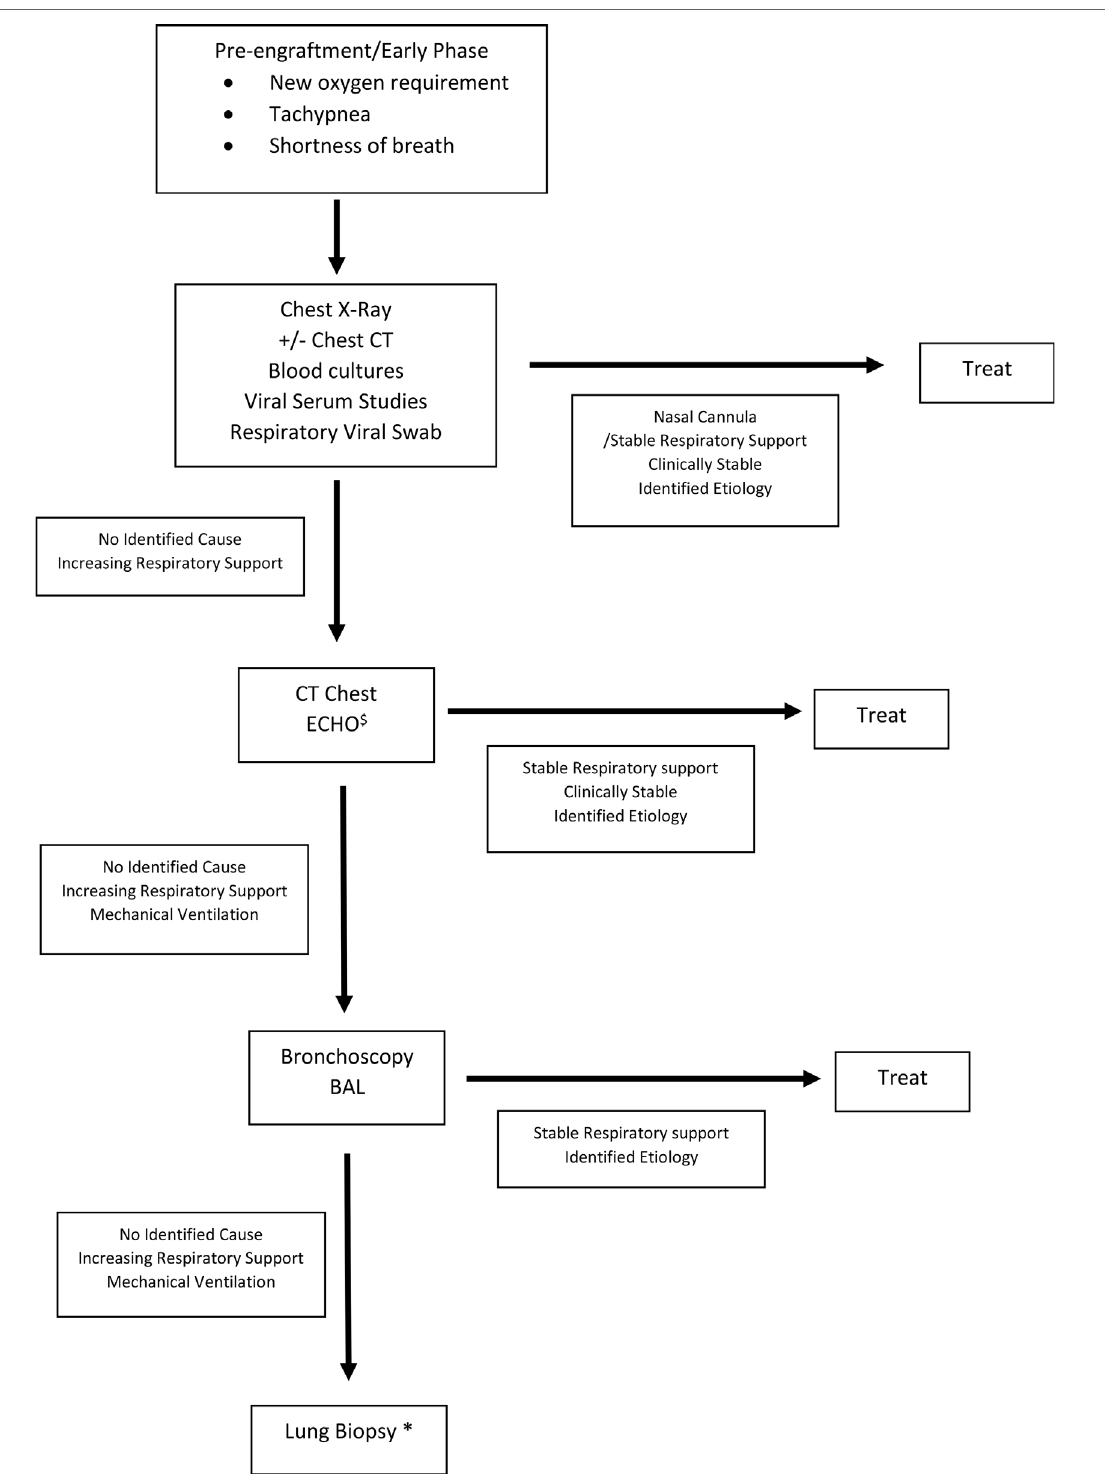
TABLE 6 | Diagnostic Algorithm of Pulmonary Complications after